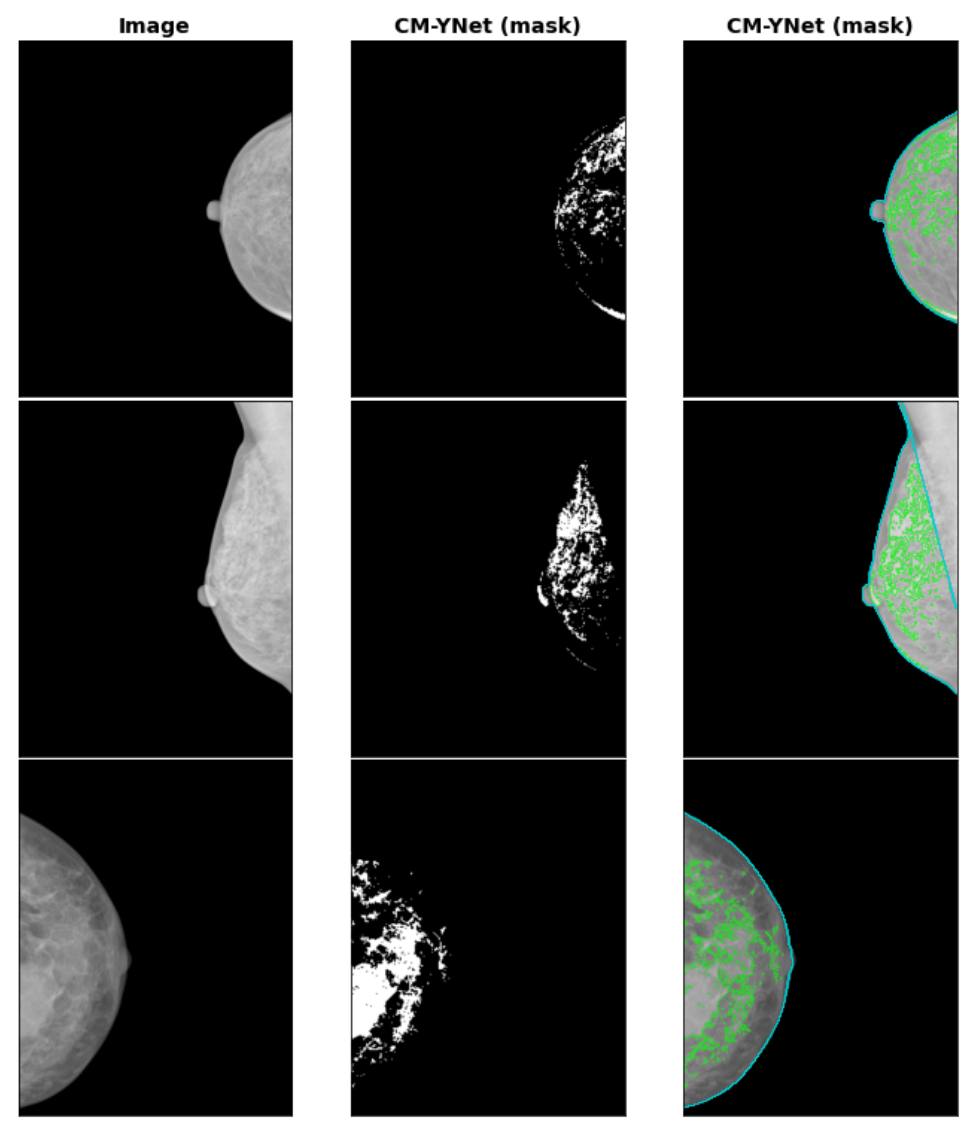
Figure 10. Segmentation examples for CM-YNet (mask) on the INbreast